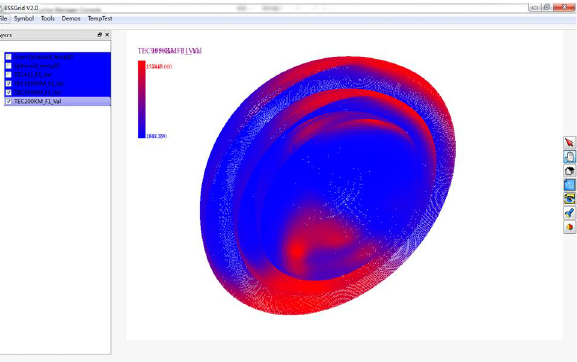
Figure 7. 3D distribution of ionosphere in three different layers using ESSG